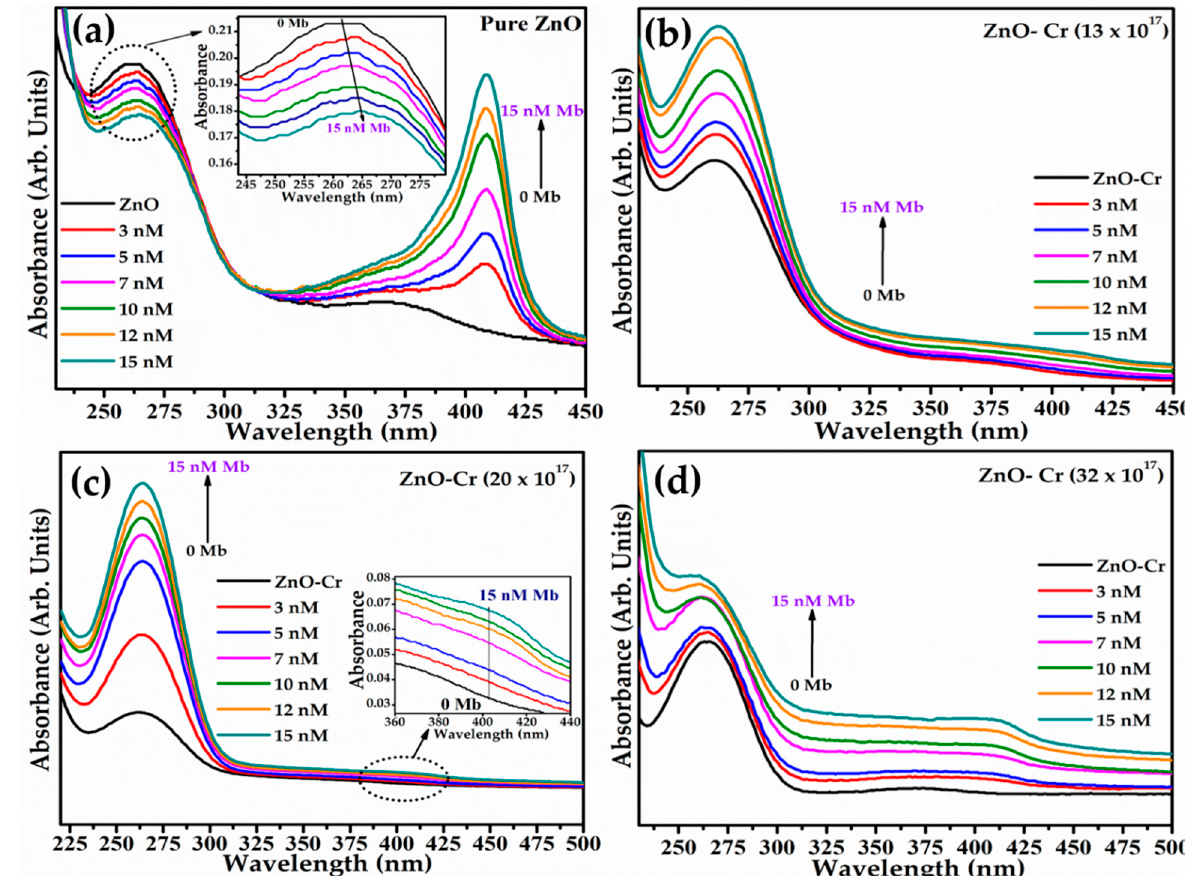
Figure 4. UV–Vis absorption spectra of synthesized pure and Cr-doped ZnO NPs with various concentrations of Mb. ( a ) Pure ZnO, ( b ) ZnO-Cr (Cr = 13 × 10 17 atoms/cm 3 ), ( c ) ZnO-Cr (Cr = 20 × 10 17 atoms/cm 3 ), and ( d ) ZnO-Cr (Cr = 32 × 10 17 atoms/cm 3 ).